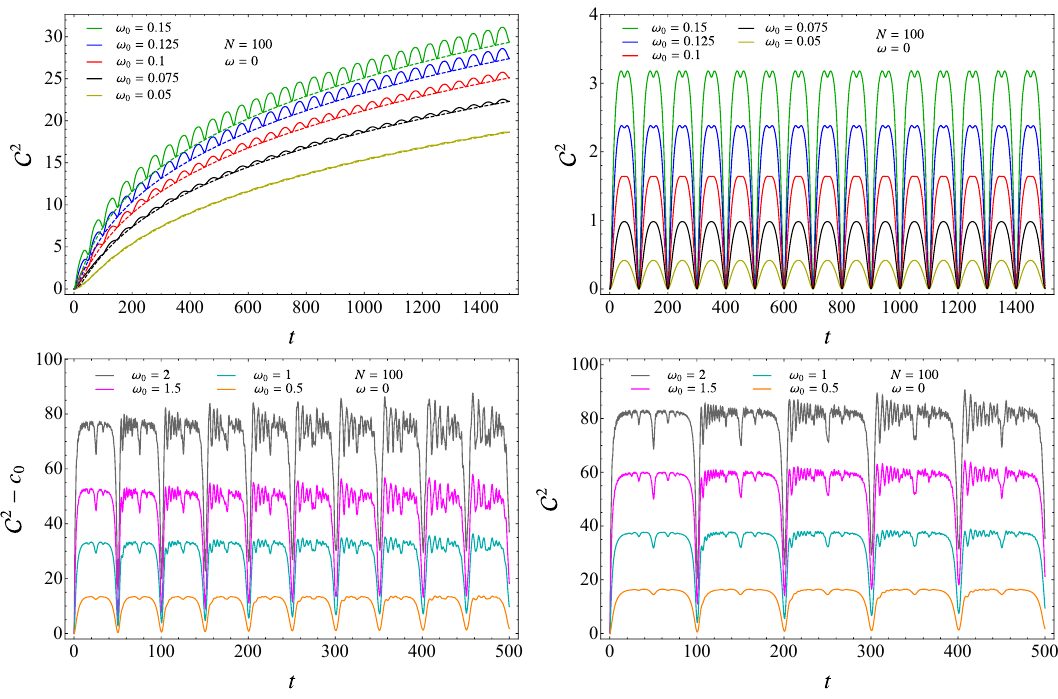
Figure 1 . Temporal evolution of the complexity after the global quench w.r.t. the initial state at t = 0 for harmonic chains with either PBC (left panels) or DBC (right panels) made by N = 100 sites. The solid lines correspond to the complexity (3.15). In the top left panel, the dashed lines show the zero mode term c 0 (i.e. the expression multiplyed by η in (3.15), which has been subtracted to obtain the bottom left panel), with the same colour code for the corresponding value of ω 0